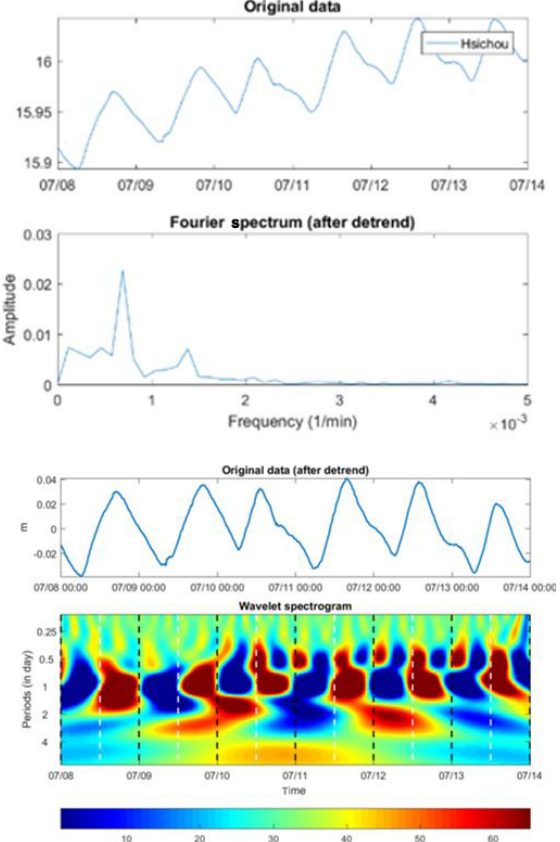
Figure 10. Groundwater levels transmitted by the IOT (top two rows) and their Fourier spectrum (left bottom) and time-frequency spectrum (right